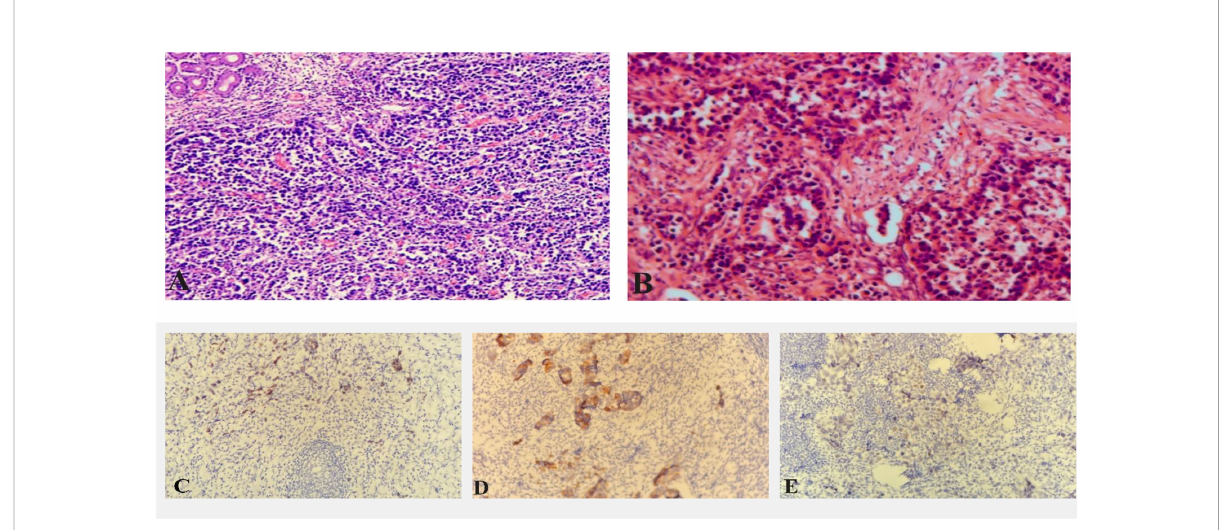
FIGURE 2 Pathological picture after radical total gastrectomy (A) ; Pathological picture after radical axillary lymph nodes (B) ; Immunohistochemical staining showed axillary lymph node tumor cells express CDX2 (C) ; Immunohistochemical staining showed axillary lymph node tumor cells express CK20 (D) ; Immunohistochemical staining showed some axillary lymph node tumor cells express SATB-2 (E)